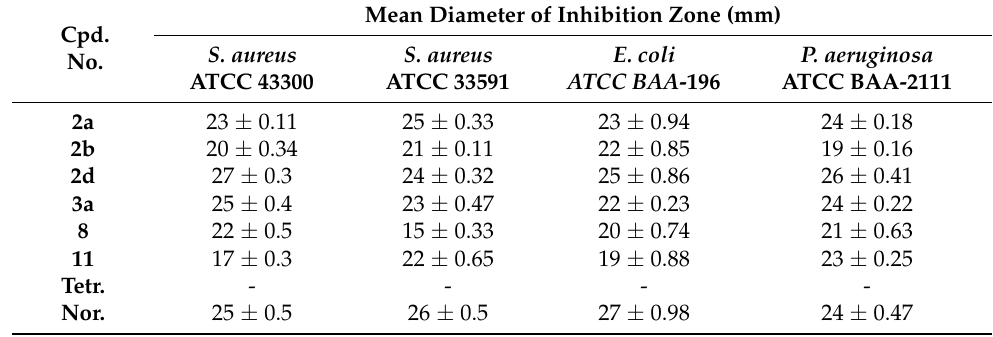
Tetr. Tetr. Tetr. Nor. Nor. Tetr. Nor. Table 5. In vitro antibacterial activity of the most promising sulfonamide derivatives, 2a , 2b , 2d , 3a , 8 , and 11 , expressed Table 5. In vitro antibacterial activity of the most promising sulfonamide derivatives, 2a , 2b , 2d , 3a , 8 , and 11 , expressed Table 5. In vitro antibacterial activity of the most promising sulfonamide derivatives, 2a , 2b , 2d , 3a , 8 , and 11 , expressed Table 5. In vitro antibacterial activity of the most promising sulfonamide derivatives, 2a , 2b , 2d , 3a , 8 , and 11 , expressed in µ M, against the multidrug-resistant strains (MDRS). in µM, against the multidrug-resistant strains (MDRS). in µM, against the multidrug-resistant strains (MDRS). in µM, against the multidrug-resistant strains (MDRS). Table 5. In vitro antibacterial activity of the most promising sulfonamide derivatives, 2a , 2b , 2d , 3a , 8 , and 11 , expressed in µM, against the multidrug-resistant strains (MDRS). Cpd. Cpd. Cpd.